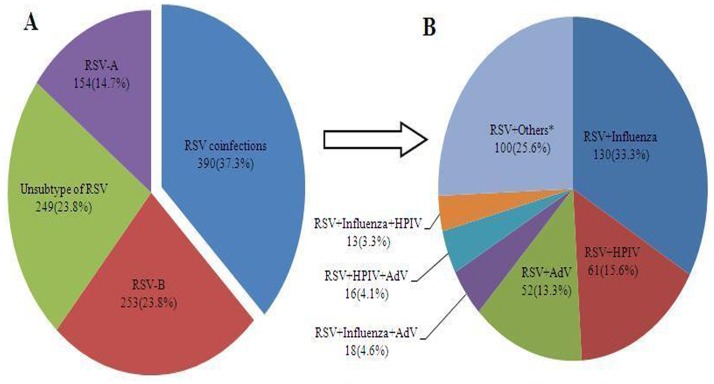
Patients with laboratory-confirmed RSV infection.(A) Distributions of RSV subtypes and coinfections among 1046 patients. (B) Distributions of other viral infections among 390 patients with RSV coinfections. *Others indicated RSV+HBoV+RV, RSV+EV, RSV+CoV, or RSV+HMPV, as less than 13 cases of each were noted. HPIV, human parainfluenza virus; HBoV, human bocavirus; AdV, adenovirus; RV, rhinovirus; CoV, coronavirus; HMPV, human metapneumovirus; EV, enterovirus.